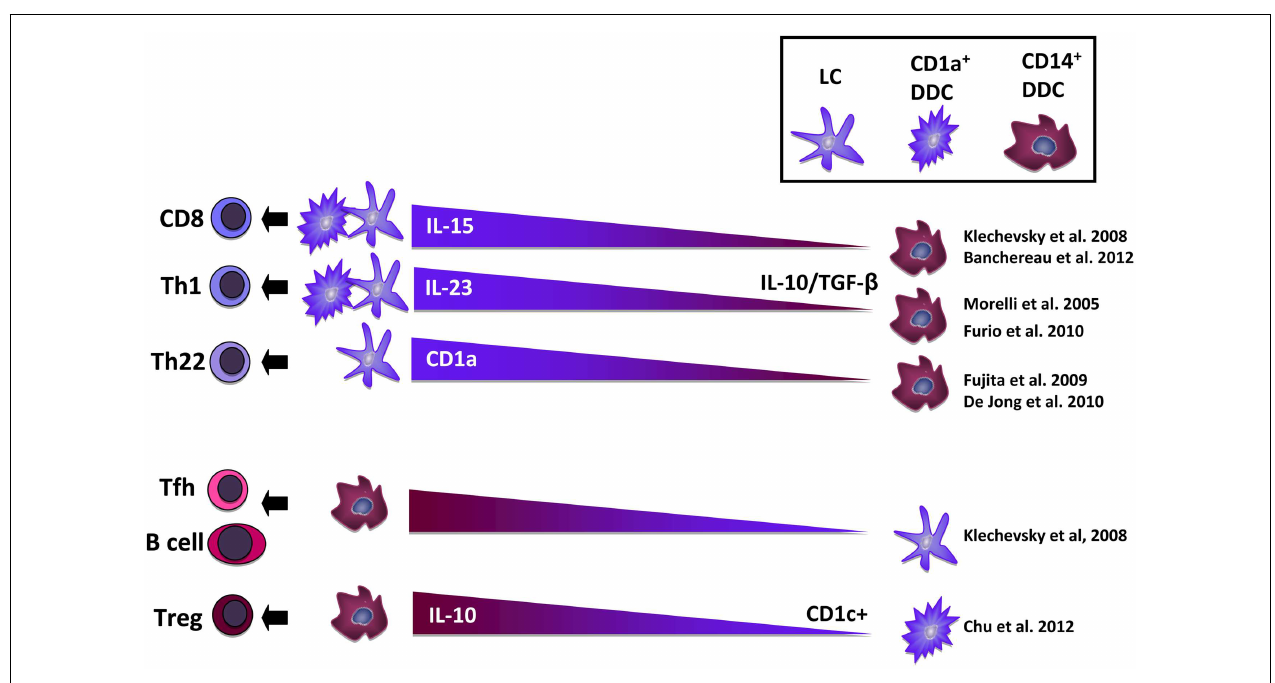
dendritic cell; IL, interleukin; LC, Langerhans cell;Th,T helper cell;Tfh,T follicular helper cell;Treg,T regulatory cell;TGF- β , transforming growth factor – β